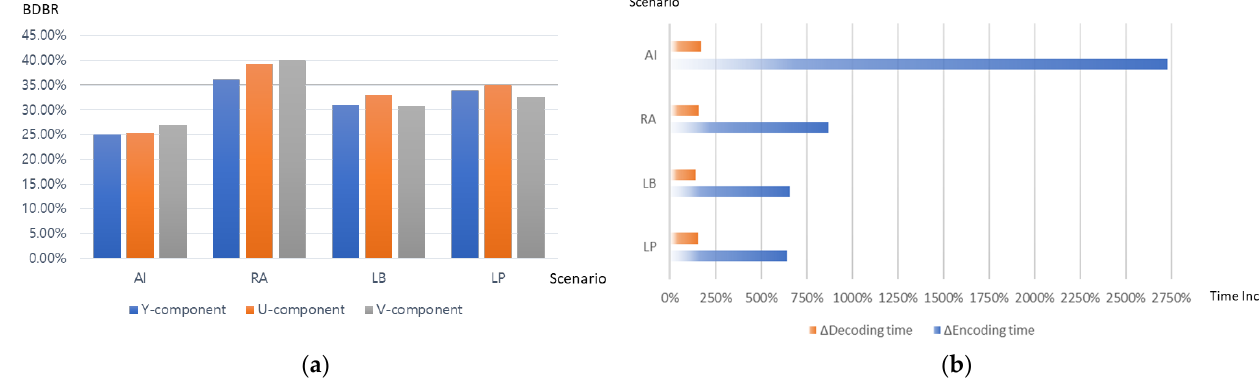
Figure 2. VVC/H.266 performance compared to HEVC/H.265. ( a ) VVC/H.266 coding performance over HEVC/H.265, and ( b ) VVC/H.266 complexity compared to